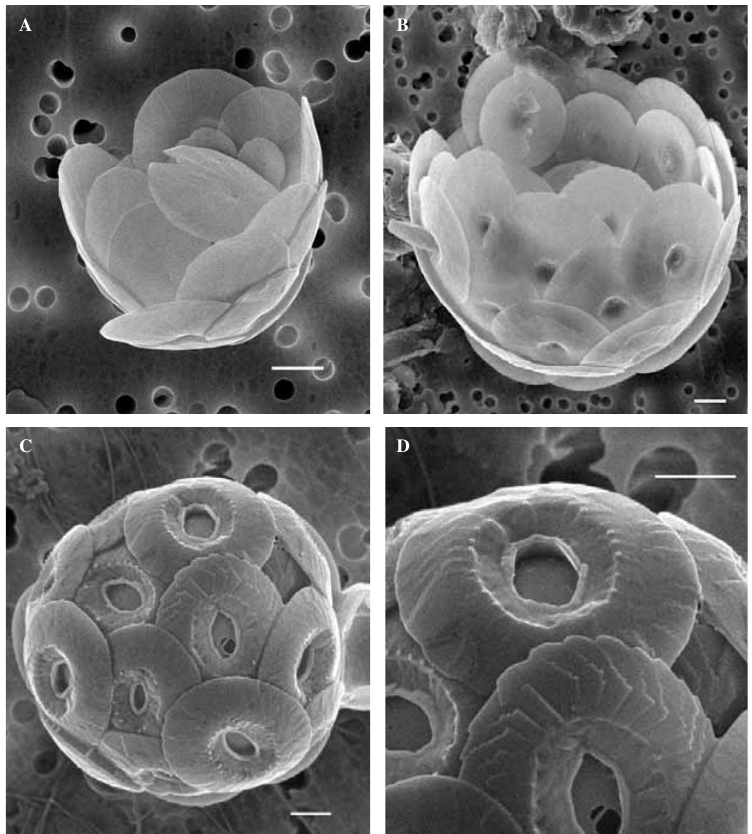
of Fig. C . Scale bars: A, B = 2 μm; C, D = 1